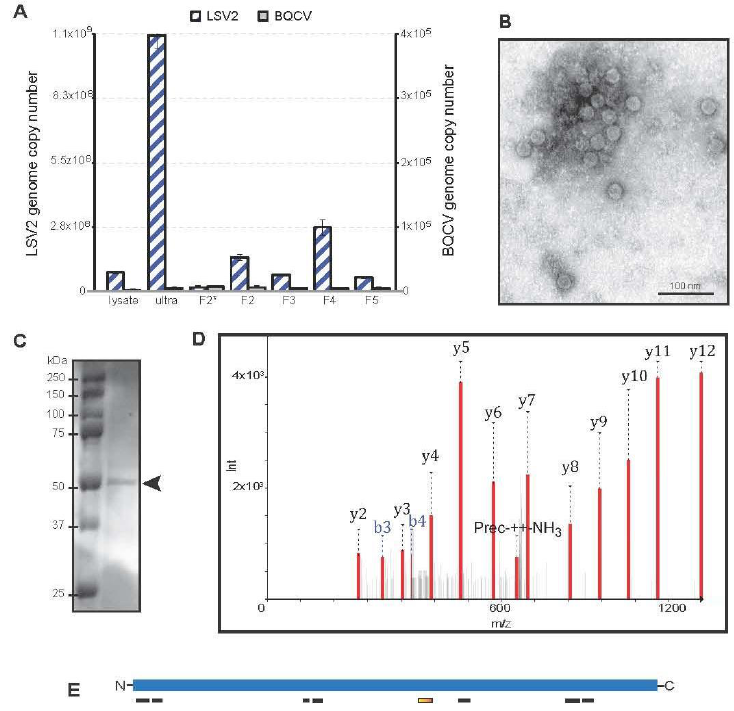
Figure 5. Characterization of Lake Sinai virus 2 (LSV2). A standard virus purification protocol was used to isolate honey bee associated viruses from bees primarily infected with LSV2; pathogen specific PCR was used to screen samples for additional pathogens (see Supplementary Figure S7). ( A ) The relative abundance of LSV2 and BQCV in several virus